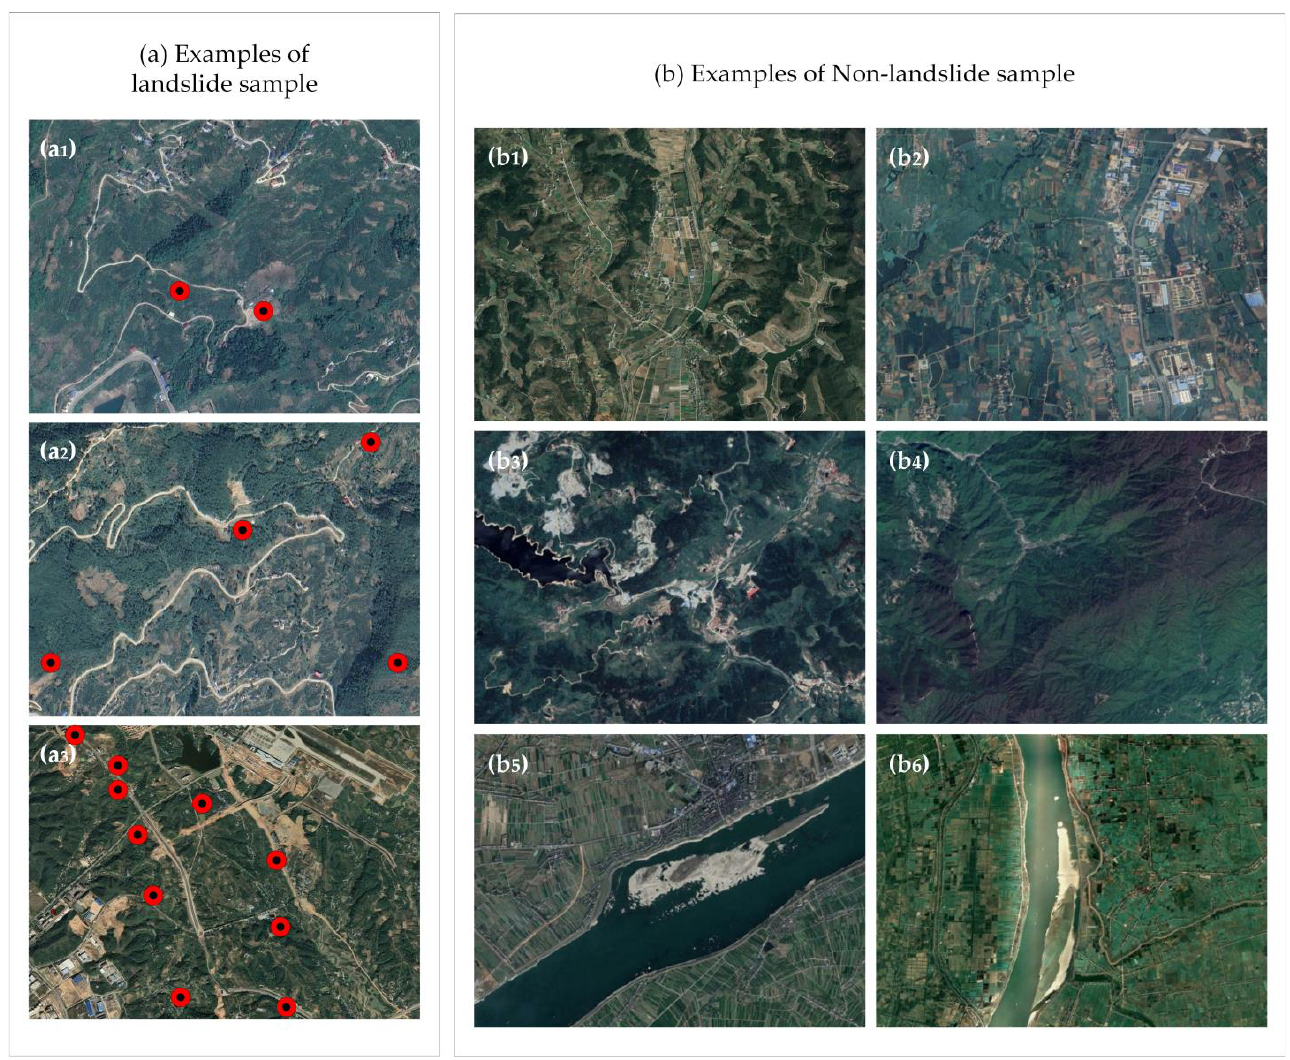
Figure 9. Examples of non-landslide sample. ( a ) Examples of landslide sample; ( b ) Examples of Non-landslide sample; ( a 1 – a 3 ) Landslide samples from different regions; ( b 1 , b 2 ) Landslide samples from different towns; ( b 3 , b 4 ) Landslide samples from different mountains; ( b 5 , b 6 ) Landslide samples from different mountains.